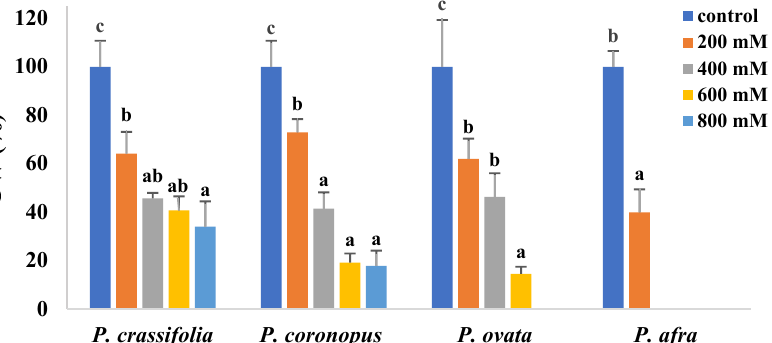
Figure 2. Fresh weight (FW) reduction of the aerial part of the plants in the four selected Plantago species after four weeks of treatment with the indicated NaCl concentrations. For each species, different letters over the bars indicate significant differences between treatments, according to the Tukey test ( p < 0.5). Values are shown as percentages of the FW of the corresponding controls, taken as 100%.